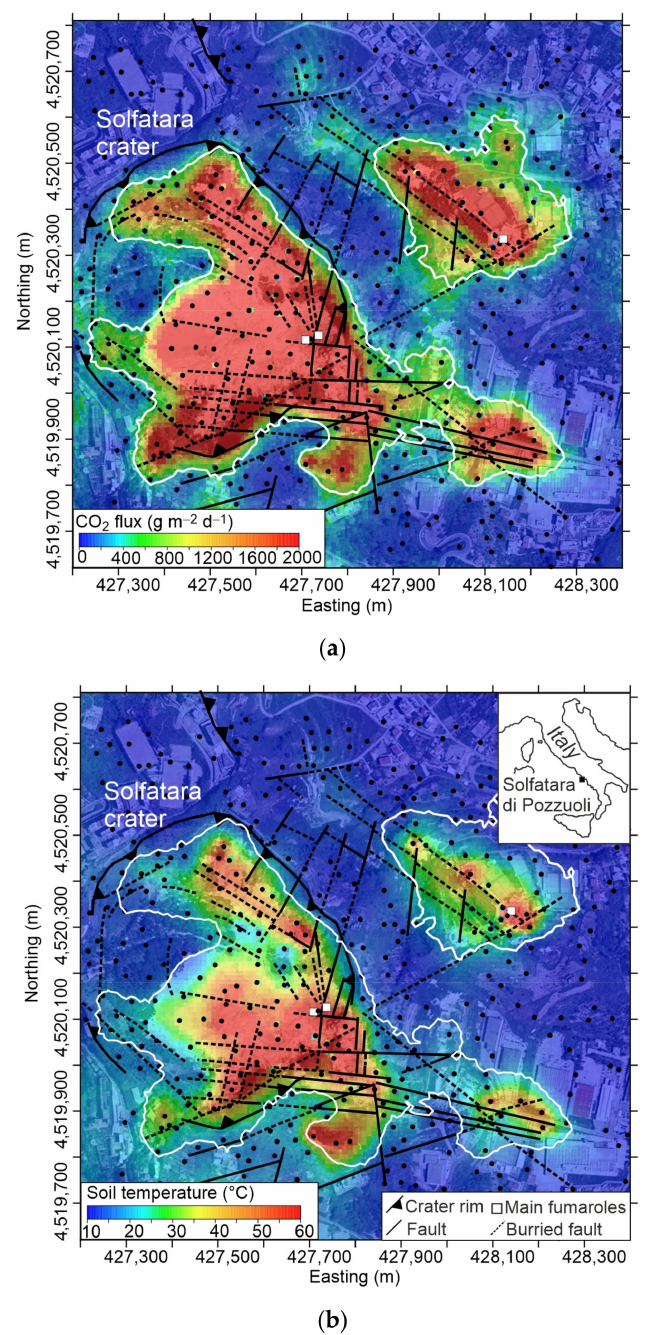
Figure 2. ( a ) CO 2 flux; ( b ) soil temperature maps of the Solfatara di Pozzuoli in December 1998. The two maps were realised using 200 sGs. In the figure are reported the measurement points (dots) where both CO 2 flux and soil temperature were measured and the contour of Solfatara DDS (white line). The DDS has been defined as the area where over 50% of the 200 simulated CO 2 fluxes are higher than 50 g m − 2 d − 1 , which is assumed as a reasonable maximum value for CO 2 production by biological activity in the soil (see [22]). CO 2 flux and soil temperature data from [22]). Coordinates refer to ED 50/UTM zone 33